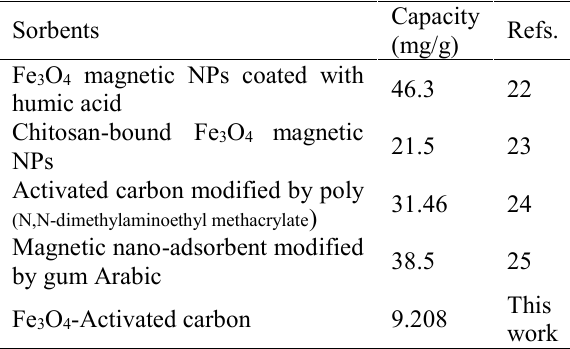
Table 2. Comparison of adsorption capacity of various adsorbents for copper